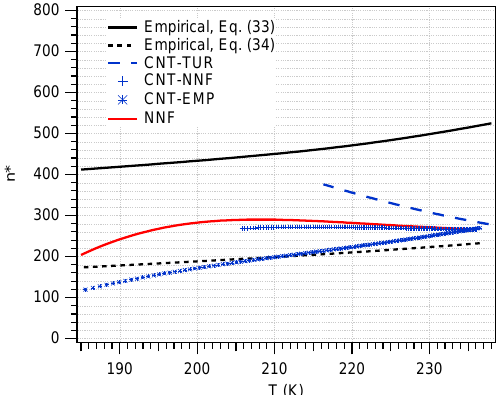
obtained using the correlations of hom was calculated using the Turnbull iw